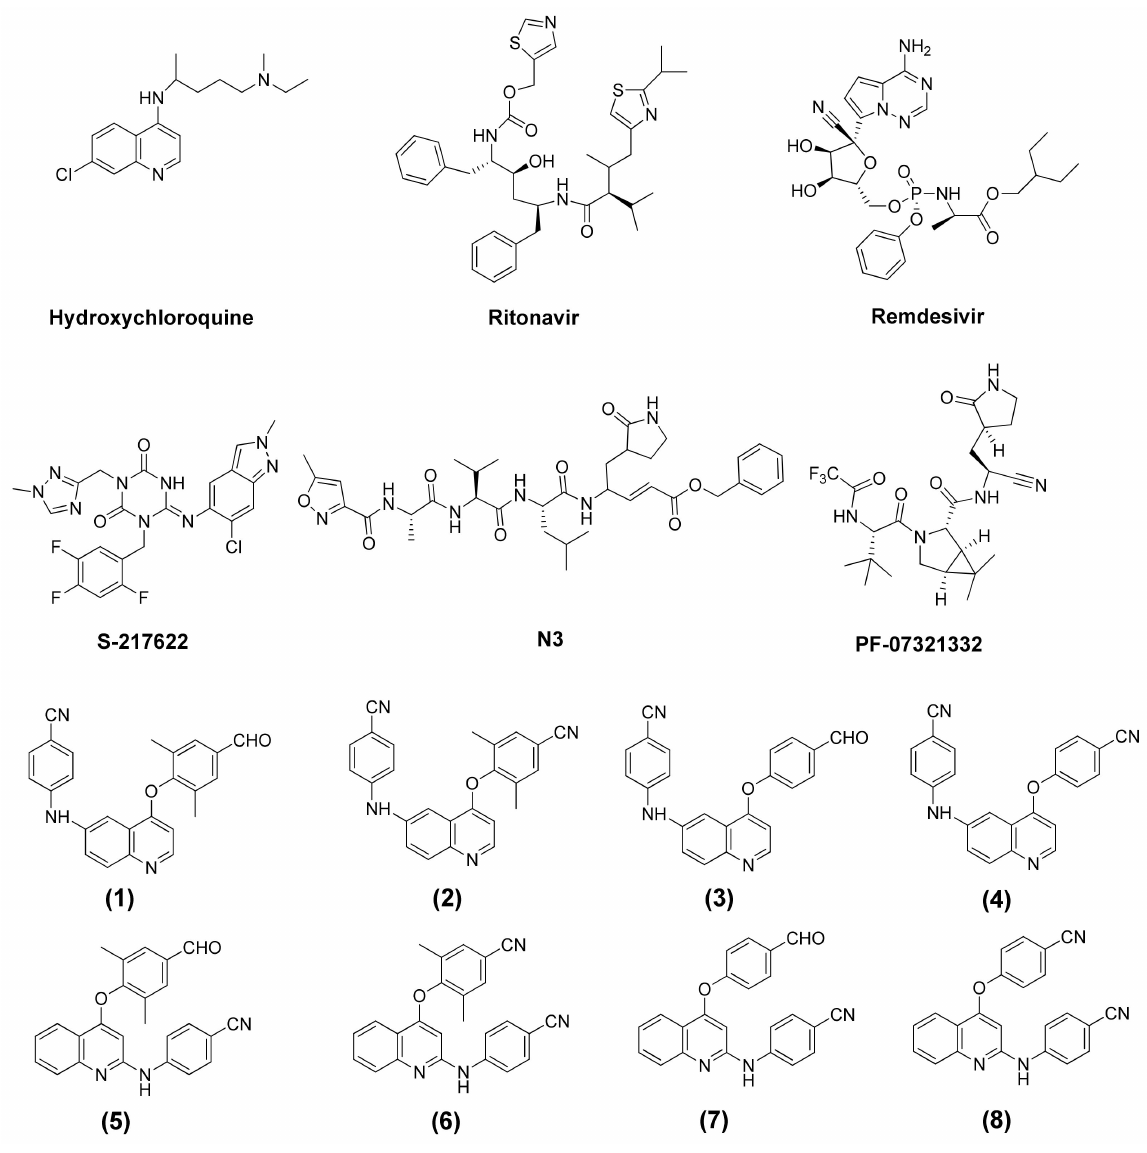
Figure 1. The structure of current medicaments and phenylamino-phenoxy-quinoline derivatives ( 1 – 8